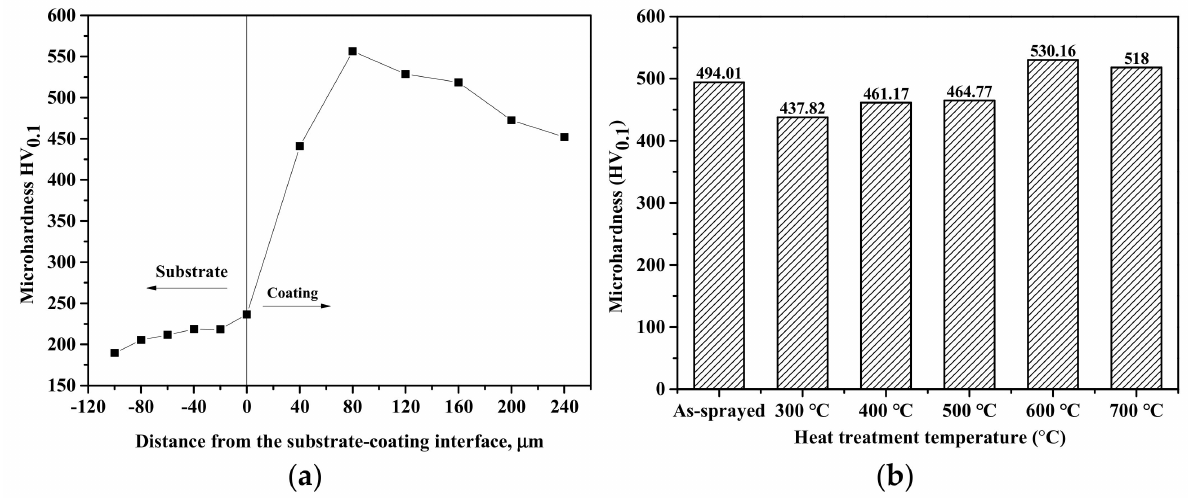
Figure 7. ( a ) Microhardness of the as-sprayed coating and substrate ( b ) average microhardness of the